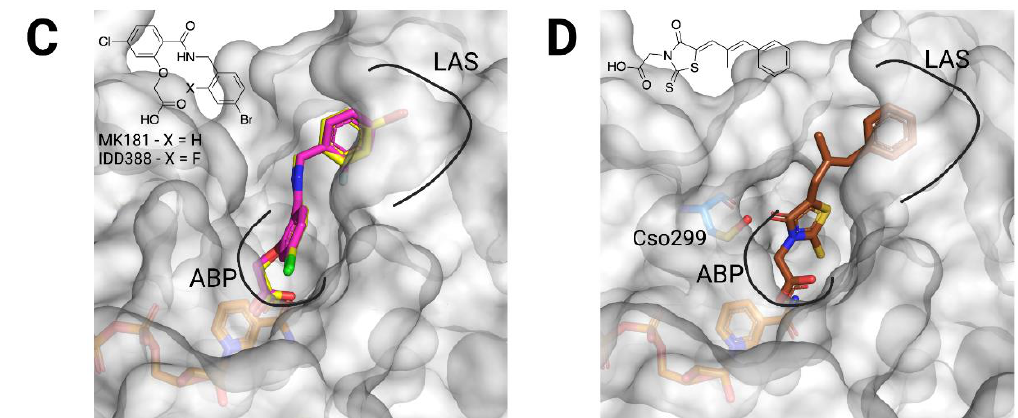
Figure 4. Structural bases for AKR1B10 selectivity (1). ( A ) Representation of the AKR1B10 (surface)-NADP + (orange)- zopolrestat (green) structure (PDB ID 4JII), with anion binding pocket (ABP), specificity pocket (SP) and Trp112 conformation indicated. ( B ) Superposition of the AR-NADP + -sulindac complex (PDB ID 3U2C, violet, yellow sticks and cyan, respectively) and of AKR1B10-NADP + -sulindac complex (PDB ID 4WEV, white, orange and green, respectively), with loop A subpocket (LAS) buried water molecules, residues Trp111/112 and Phe122/123 and loop A indicated. Adapted from Ref. [46]. ( C ) Representation of the AKR1B10 (surface)-NADP + (orange)-MK181/IDD388 (yellow/pink) structures (PDB ID 5LIK and 5LIU), with ABP and SP indicated. ( D ) Representation of the AKR1B10 (surface)-NADP + (orange)-epalrestat (brown) structure (PDB ID 4JIH), with ABP, SP and Cso299 (S-hydroxycysteine 299) indicated. Since epalrestat was just partially solved, it has been docked manually. 2D molecular structures of inhibitors are also depicted. Created with PyMoL 2.3.0. and in biorender.com.